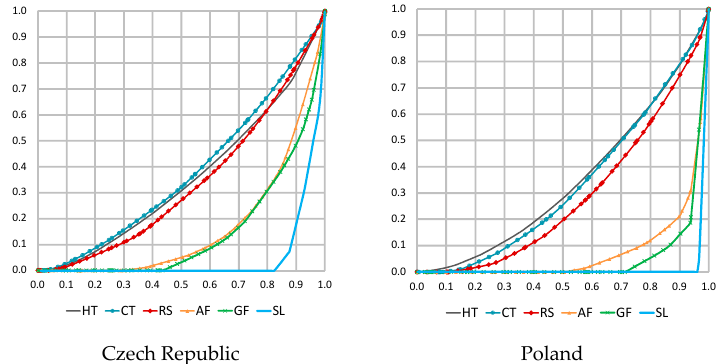
Figure 7. Spatial concentration (Lorenz curves) of tourism infrastructure in the Czech ( left ) and Polish ( right ) research areas. Note: The curves between Poland and Czech Republic cannot be compared due to differences in the number and area of the research fields clipped to the study area boundaries. Acronyms: HT—Hiking Trails; CT—Cycle Trails; RS—Roads; AF—Accommodation Facilities; GF—Gastronomic Facilities; SL—Ski Lifts. Source: authors’ own research.